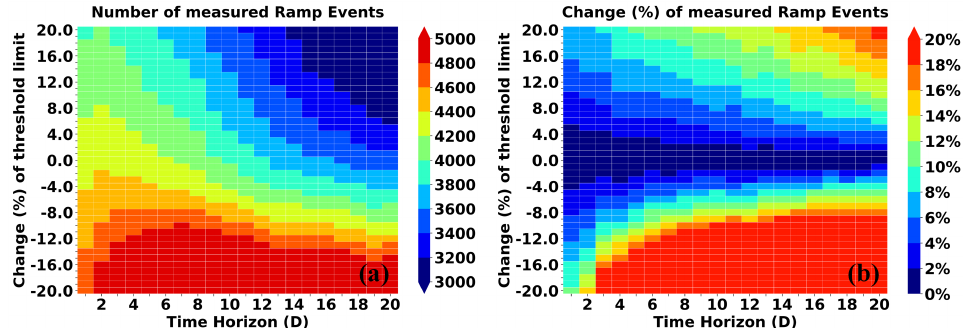
Figure 3. ( a ) Total number of measured ramp events and ( b ) the change of this number caused by varying the threshold limit (Thr) at each time horizon (D). The vertical axis shows the change of the threshold limit, whereas the horizontal axis presents D. The color bar displays the number of ramp events ( a ) and the change of the number of ramp events ( b ).